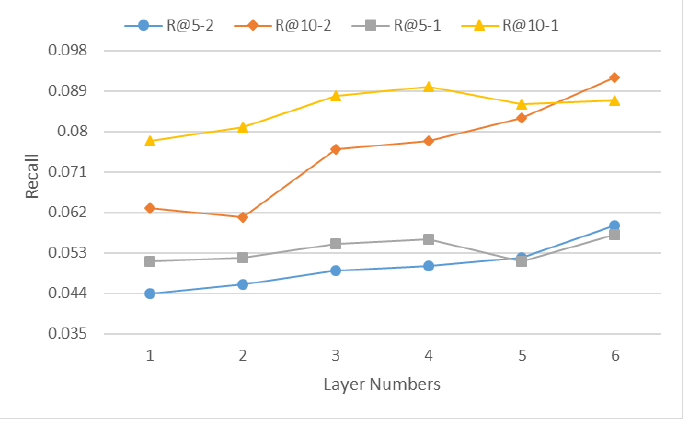
Figure 8. Recall generated by models with different numbers of layers.